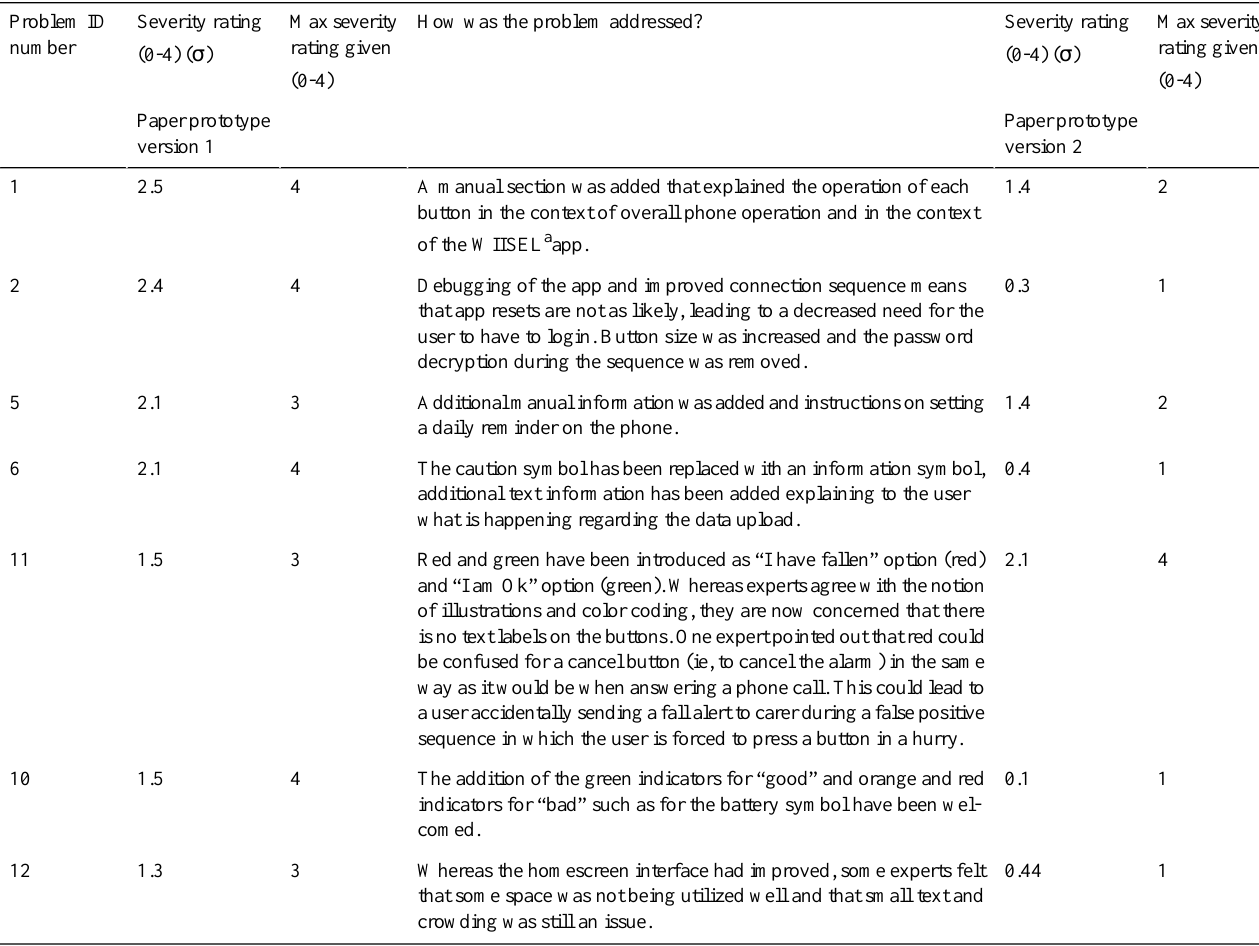
Table 10. Comparison of problem ratings between paper prototype V1 problems and the updated interface (paper prototype V2). The max individual score that was given by the 10 experts is also included to highlight the fact that some experts may have given a more severe rating than the mean or standard deviation